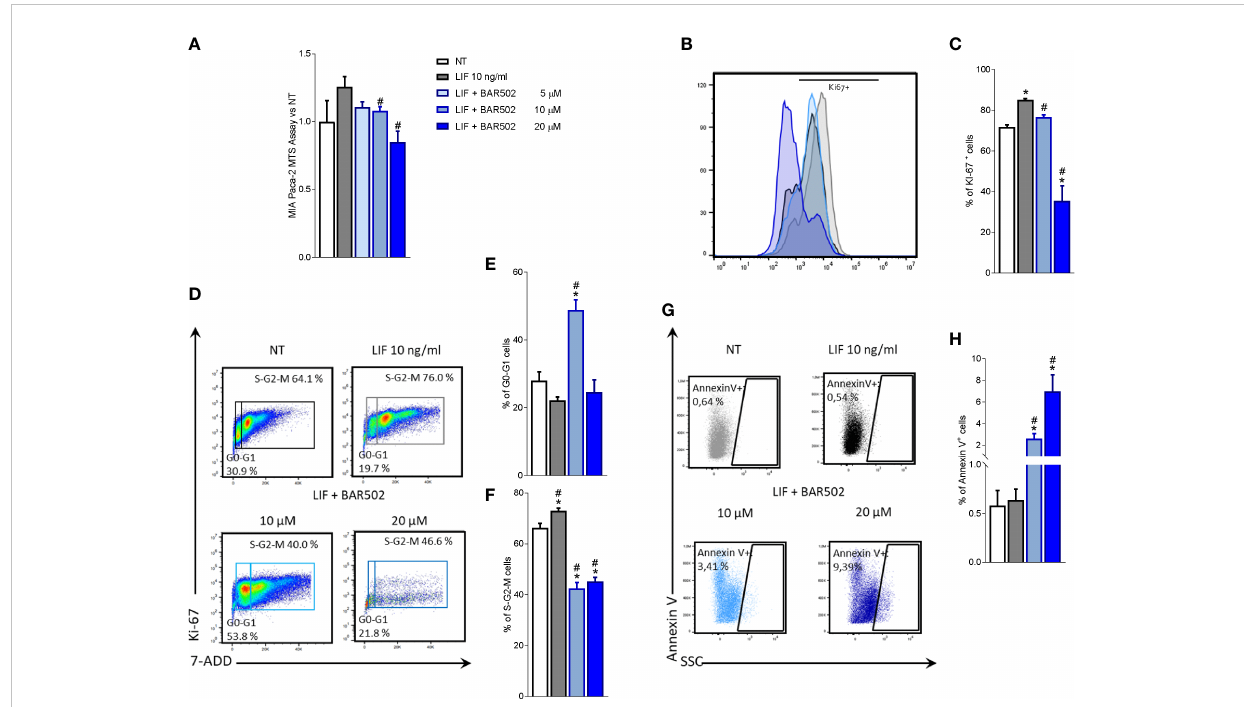
FIGURE 5 LIFR inhibition reverses PDAC cell proliferation promoted by LIF. MIA PaCa-2 cells were serum-starved and primed with LIF (10 ng/mL) alone or in combination with increasing concentrations of BAR502 (5, 10,20 m M). Data shown are (A) MTS assay performed on MIA PaCa-2. Each value is expressed relative to the non-treated (NT) value, which is arbitrarily set to 1. Results are the mean ± SEM of 10 samples per group. Cell cycle phase analysis was performed by Ki-67/7-AAD staining through IC-FACS. (B) Representative IC-FACS shows Ki-67 positive MIA PaCa-2 cells and (C) frequencies of Ki-67 positive cells. (D) Representative IC-FACS shows cell cycle fraction in each experimental group. Data shown are frequencies of cells in the (E) G0-G1 phase and (F) S-G2-M phase. (G) Representative IC-FACS shows Annexin V+ cells. (H) Data shown are frequencies of Annexin V+ single cells. Results are the mean ± SEM of fi ve samples for group (* represents statistical signi fi cance versus NT, and # versus LIF, p <